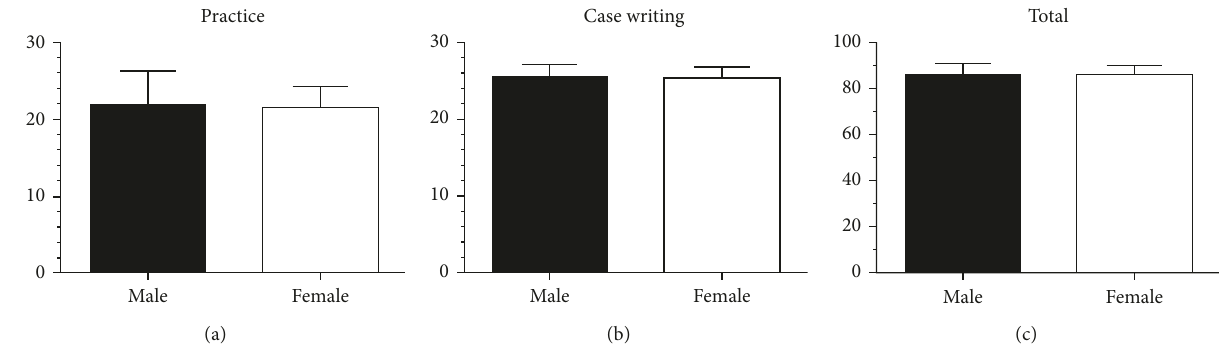
Figure 1: Comparison of scores at the end of the clerkship. The test scores between genders are represented. (a) Practice scores. (b) Case- writing scores. (c) Total scores.